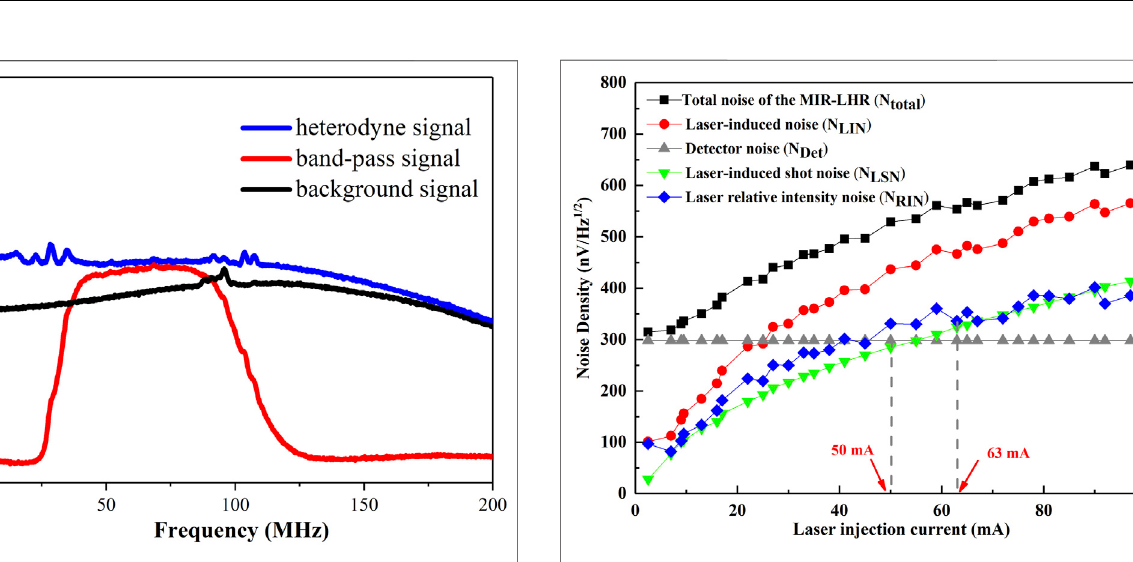
FIGURE 4 | Spectral analysis of heterodyne signal ( blue curve ); band- pass signal ( red curve ) and background signal ( black curve ).